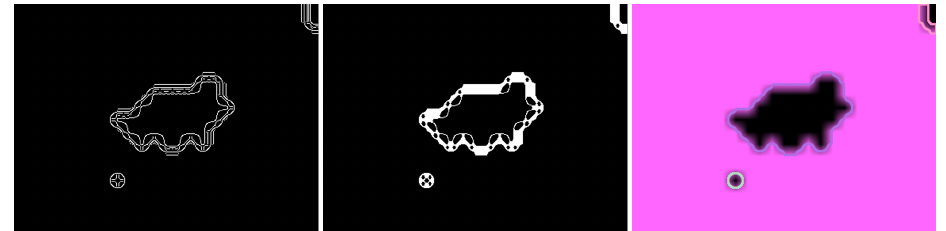
Figure 8. Contour detection pipeline; from left: Canny edge detection, morphologic closing, chain